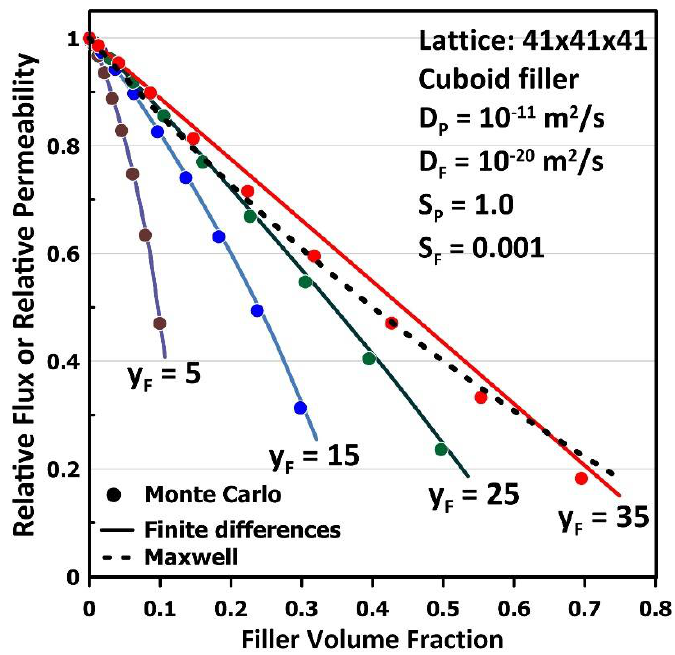
Figure 7. The plot of the relative steady-state flux or relative permeability of an MMM with an impermeable cuboid filler for four different thicknesses ( y F ) on lattice discretization of 41 × 41 × 41. The other two dimensions ( x F = z F ) were increased to augment the filler volume fraction. Results were compared with the results of the FD method under identical conditions.